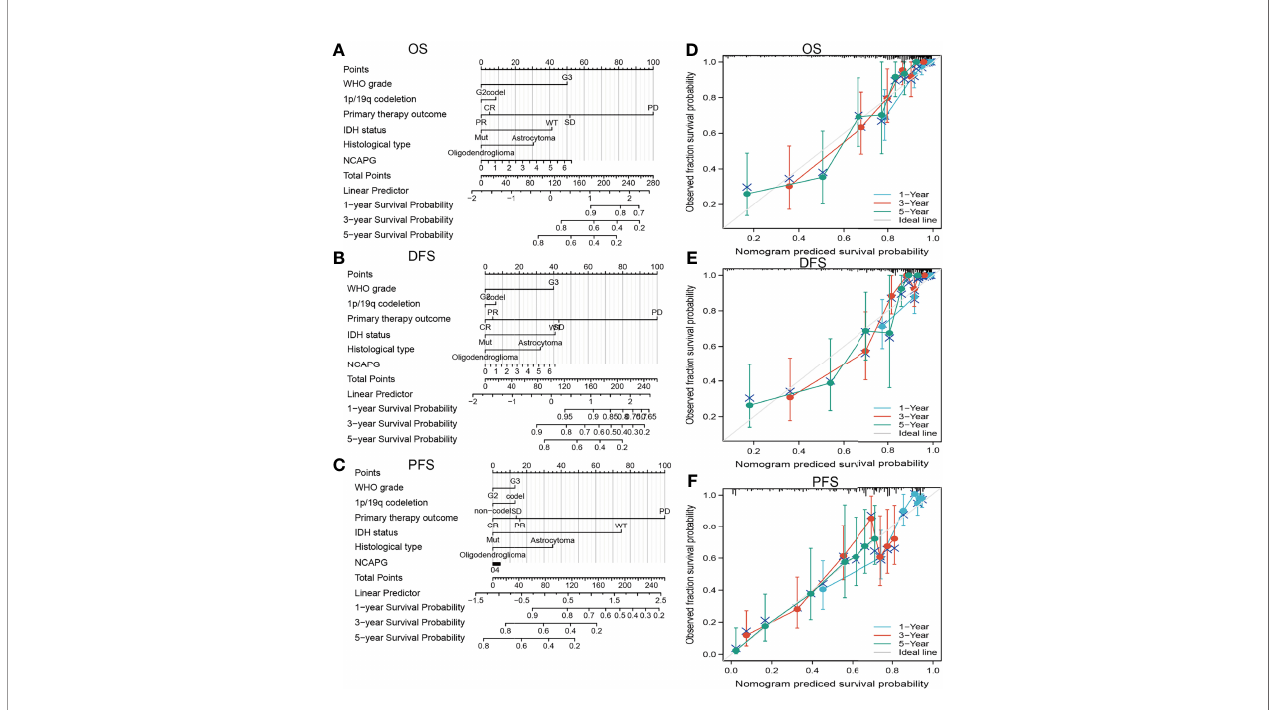
FIGURE 4 | Construction a nomogram to predict the prognosis of NCAPG in glioma. Construction of a nomogram to predict the (A) OS, (B) DFS, and (C) PFS in patients with glioma. The calibration curve used to display the TCGA-glioma cohort for (D) OS, (E) DFS, and (F)